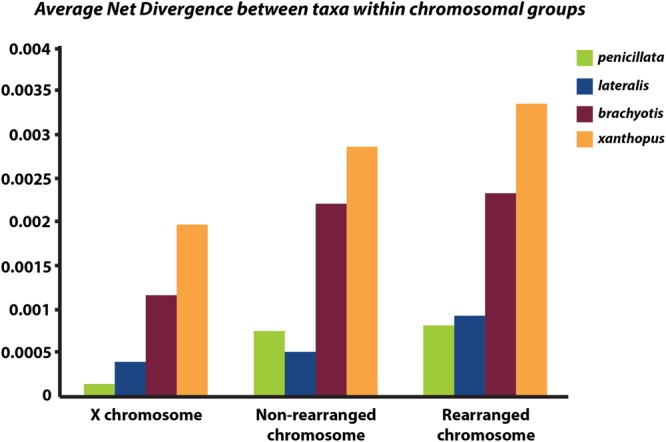
Graph of average net divergence between taxa within each chromosomal group: brachyotis, lateralis, penicillata, and xanthopus. Divergences are estimated for loci on the X chromosome, non-rearranged chromosomes (2,4,7,8) and rearranged chromosomes (5,6,9,10).